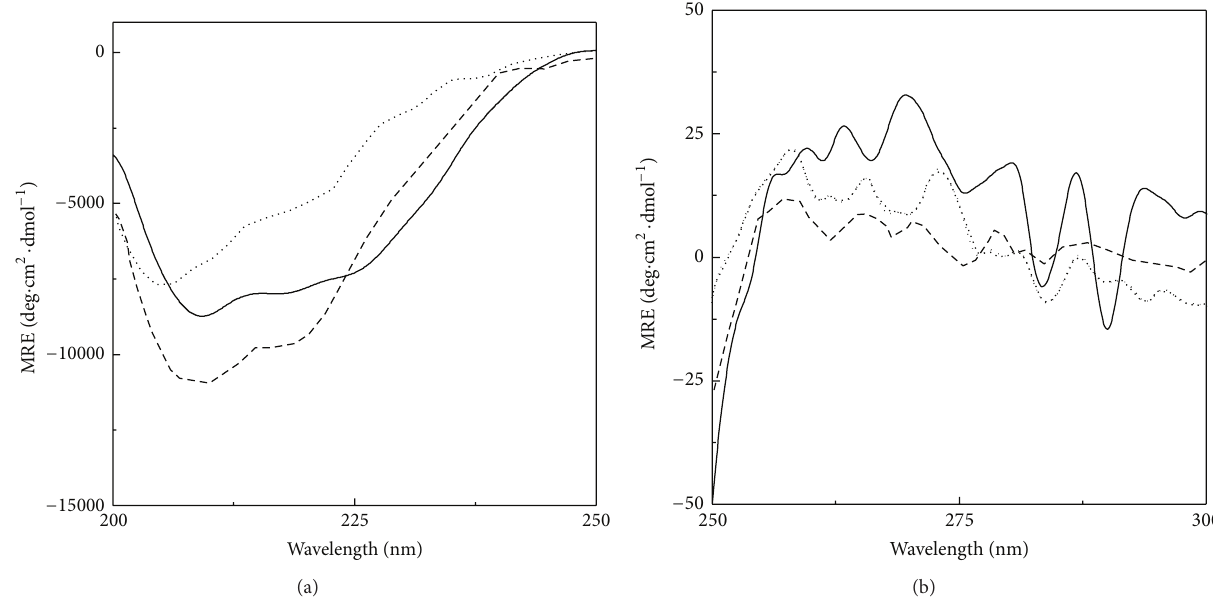
Figure 2: Far-UV (a) and near-UV (b) CD spectra of different conformational states of BLA, as obtained at 25 ∘ C using a protein concentration and cuvette path length of 1.7 𝜇 M; 1mm and 3.4 𝜇 M; 10 mm for far-UV and near-UV CD spectral measurements, respectively. Native state (—), acid-denatured state ( ⋅ ⋅ ⋅ ), and HFIP-induced state